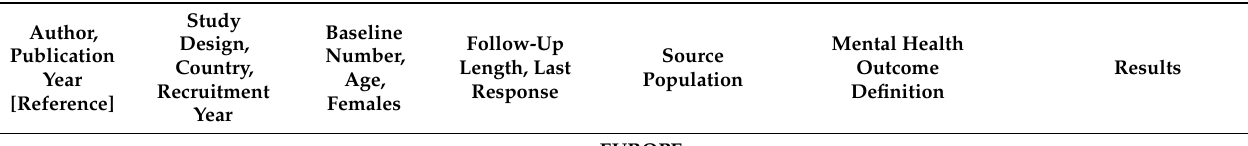
Table 2. Basic characteristics and results of longitudinal observational studies of good quality on mental disorders comparing self-employed (s-empl) vs. employees